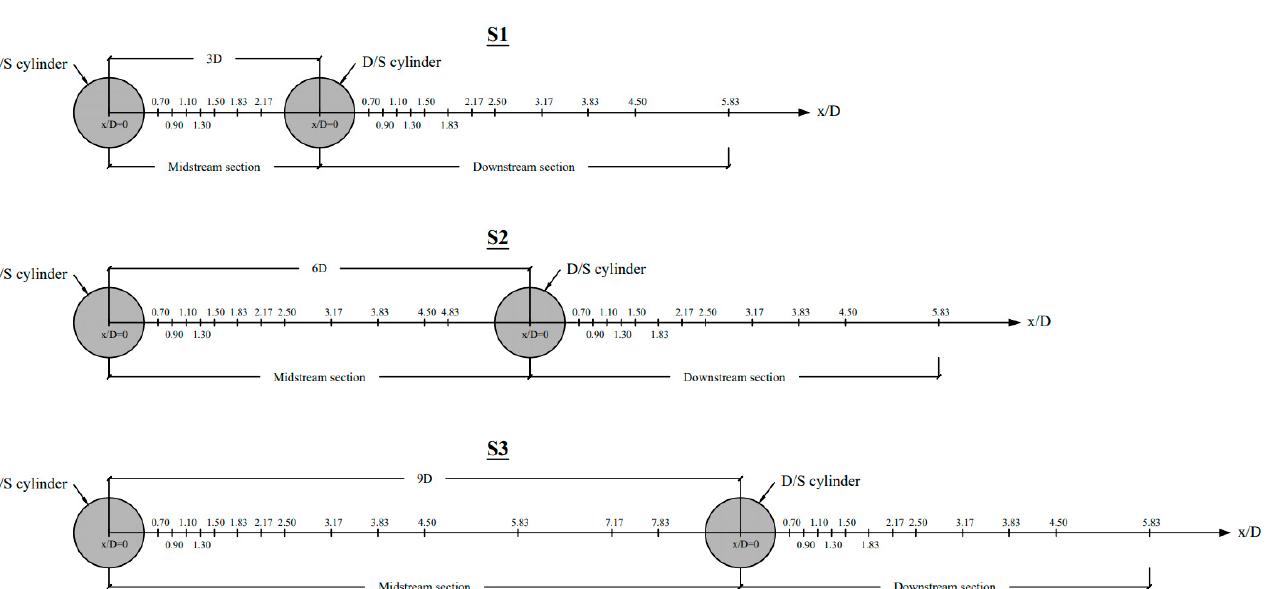
Table 1. Details regarding the experimental